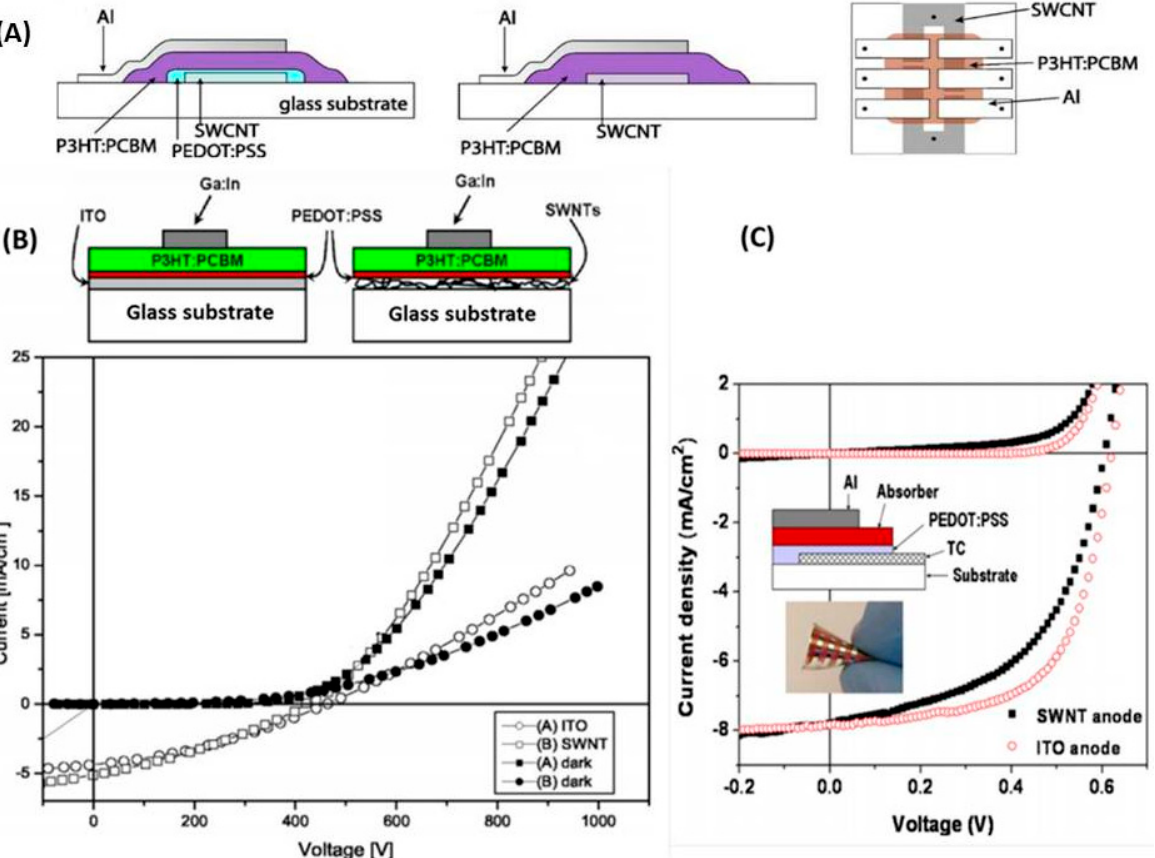
Figure 2. Various approaches to incorporate CNTs in the hole harvesting or conducting components of a polymer solar cell. ( A ) In first diagram, only ITO is replaced by the SWCNT layer, in second diagram both PEDOT:PSS and ITO are replaced by the SWCNT layer, while third one is sowing the top view of the device structure in which the black dots represent the points where contacts are made; ( B ) Schematic of the devices with ITO and SWNT thin film as the anodes are shown in the upper panel. The corresponding I-V curves at 100 mW/cm 2 halogen white light and in the dark of reference solar cell on ITO-glass substrate and best solar cell using a SWNT-glass current collector are shown in the lower panel; ( C ) shows the potential flexibility using CNTs and a polymer substrate. (A) Reproduced from [66] with permission; (B) adapted from [68] and reproduced with